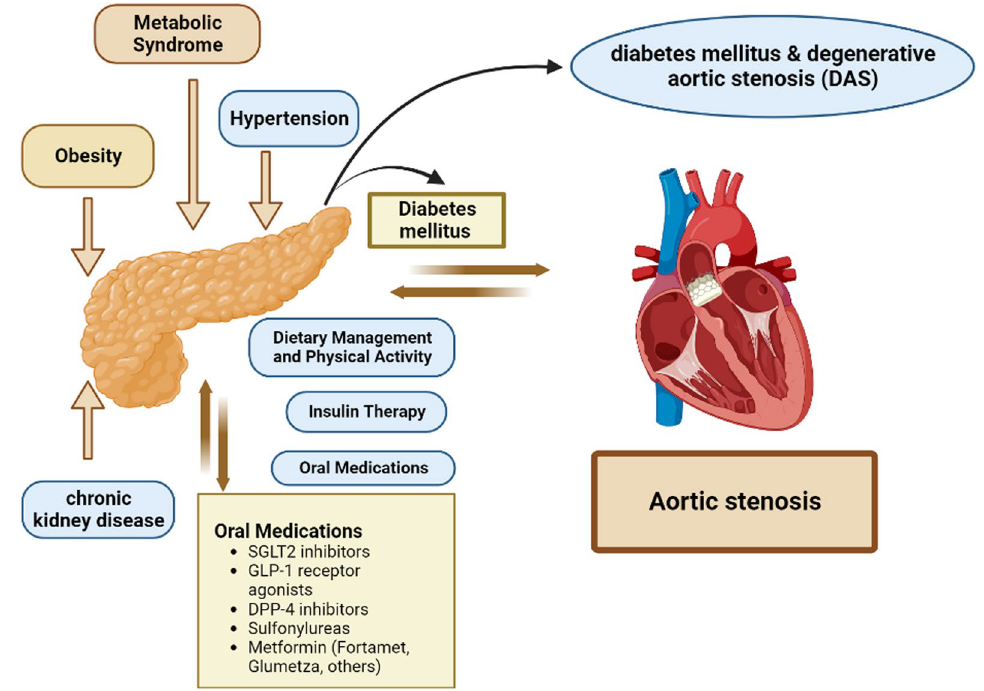
Fig. 3 Correlation between Diabetes Mellitus and Aortic